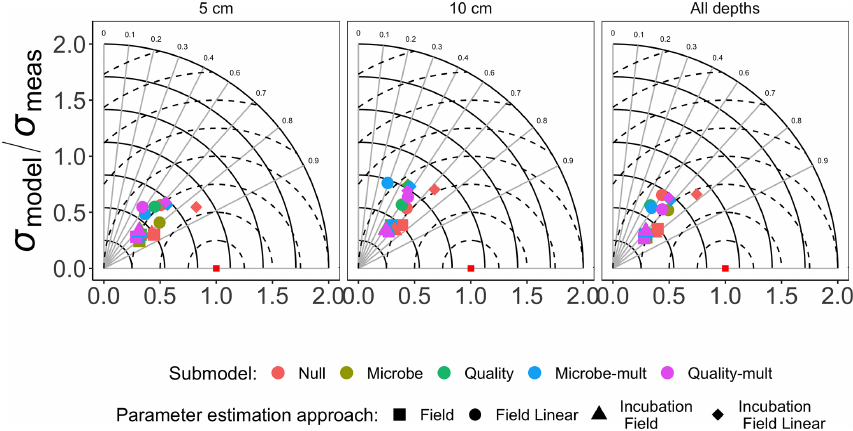
Figure 4. Taylor diagram for comparing measured and modeled R S for field data for each of the FireResp submodels (colors) and parameter estimation approaches (symbols). Columns in the facetted plot represent the depth of the data used for parameterization (5cm, 10cm, or all depths). Radii represent the normalized standard deviation between a FireResp submodel value of R S and measured R S ; angles represent the correlation coefficient r (labeled). The dashed concentric circles represent contours (increments 0.25) for the normalized centered-pattern root mean square